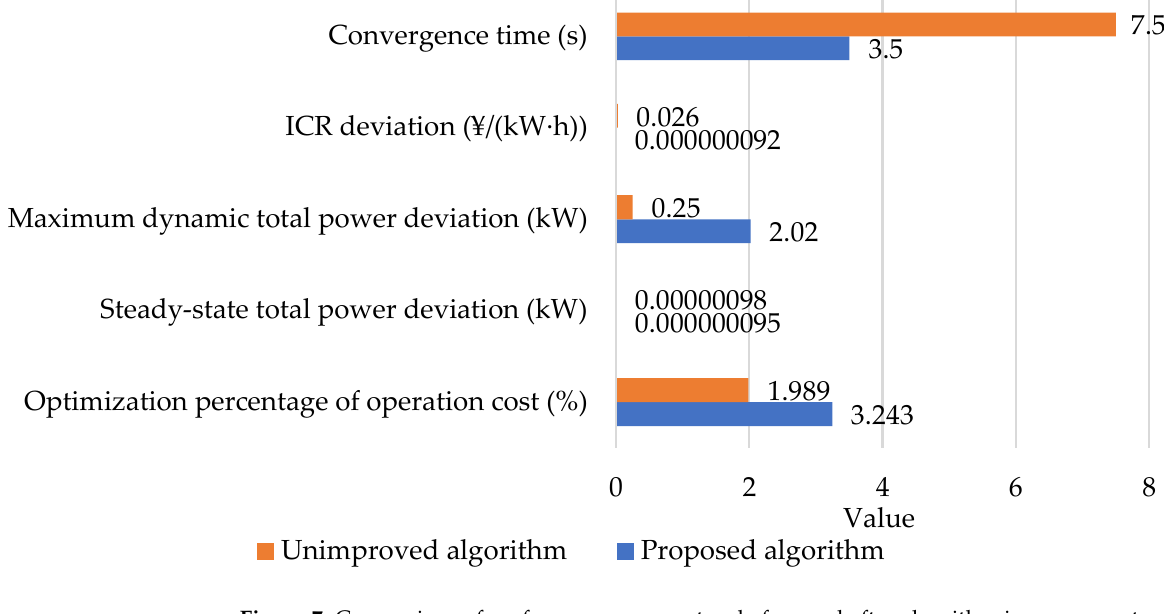
Figure 7. Comparison of performance parameters before and after algorithm improvement.